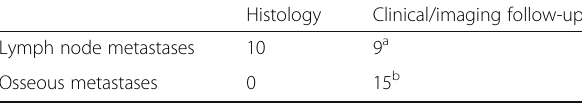
Axial LAVA-FLEX a